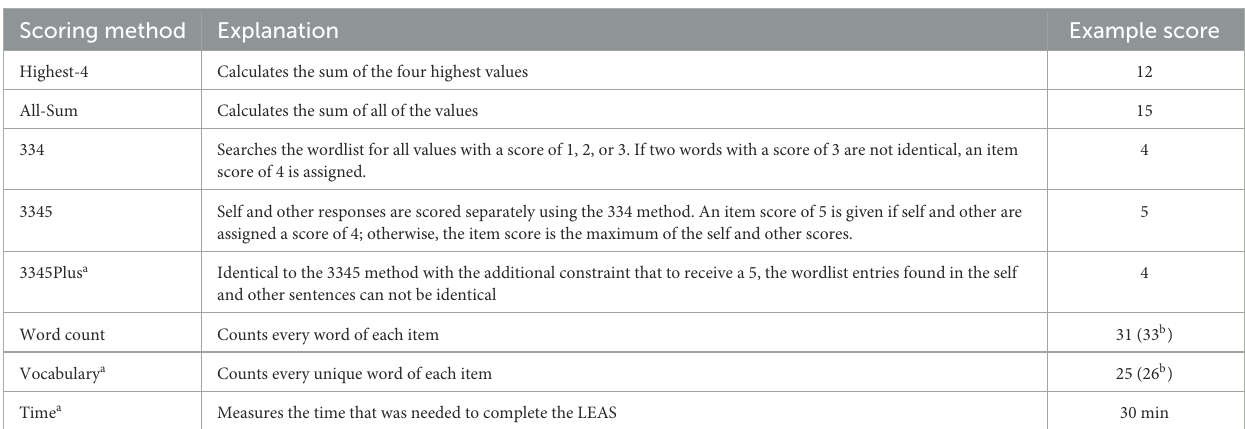
TABLE 3 Scoring methods.